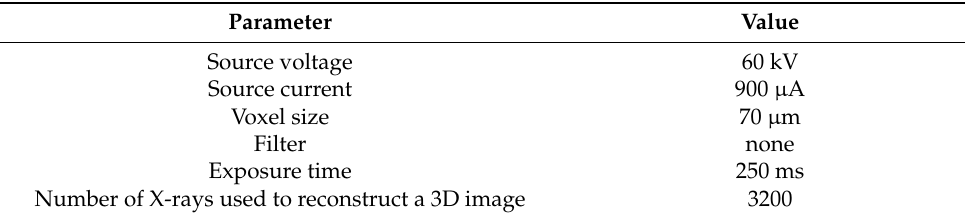
Table 1. Parameters of the X-ray CT